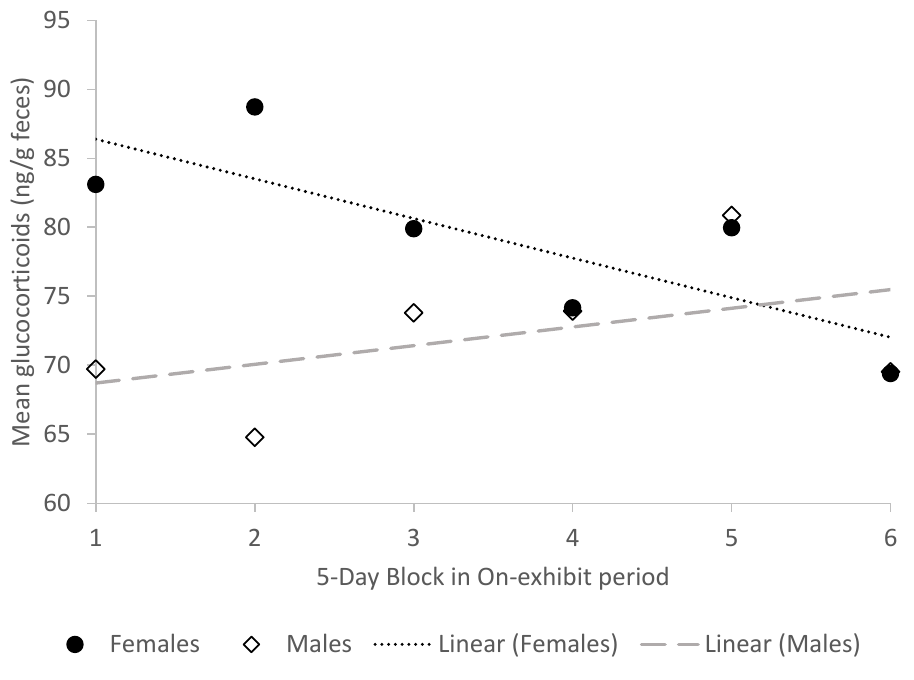
Figure 4. Mean fecal glucocorticoid concentrations (N gpigs = 16, N samples = 344) in male and female guinea pigs across five-day blocks during on-exhibit periods. There is a significant decrease in glucocorticoids in females ( p < 0.05) and a significant increase in glucocorticoids in males over time while on exhibit ( p < 0.05).